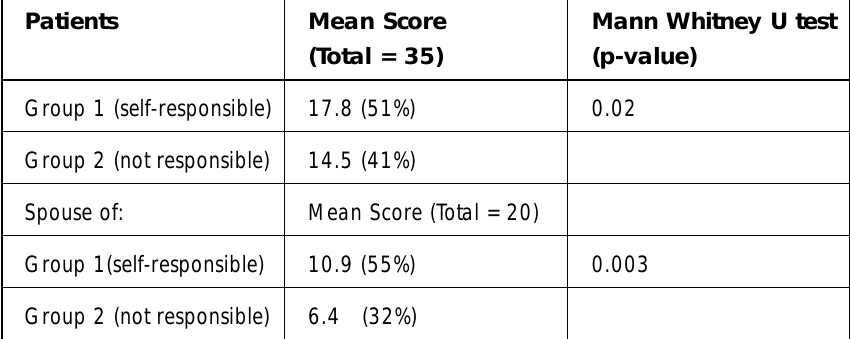
Table 1X: Self-Responsibility - Knowledge Scores (Twelve Months after